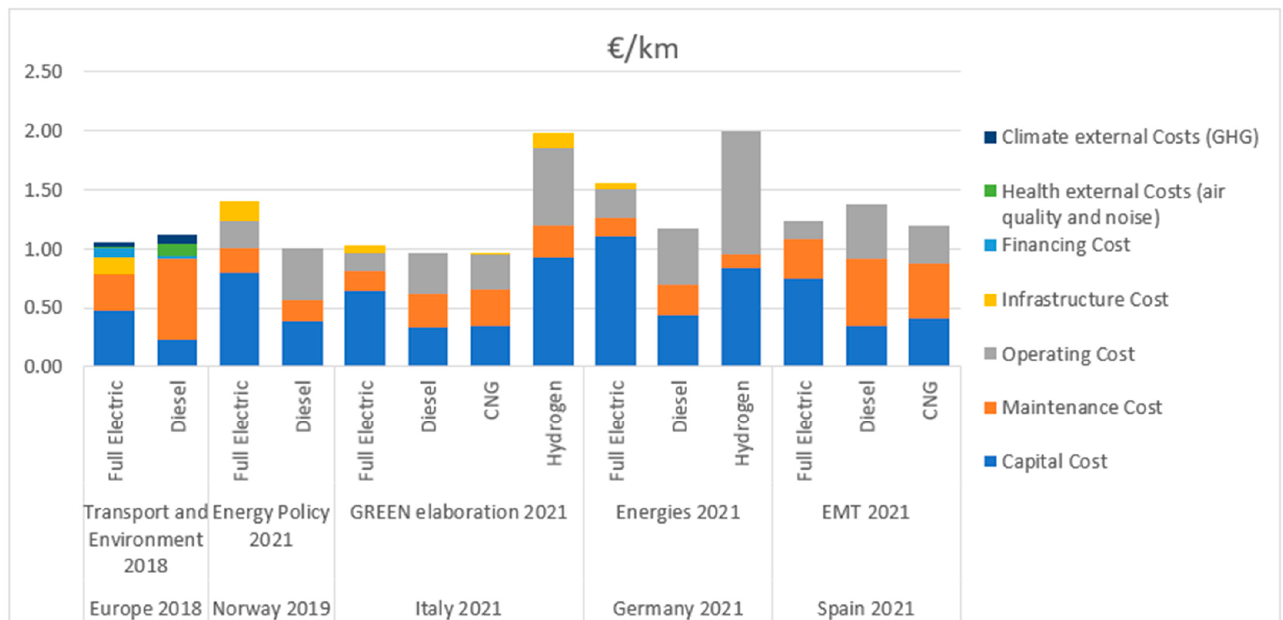
Figure 8 . TCO of EMT of Madrid compared with other TCO publications. Figure 8. TCO of EMT of Madrid compared with other TCO